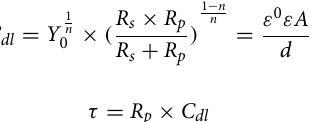
In this equation, R p,0 and R p, i denote the polarization resistance of MS in the inhibitor-free and inhibitor-con- taining solution, respectively. Compared to the blank solution, the sample submerged in the inhibitor-containing solution has a greater R p , as shown in Table 1. It is worth mentioning that as the concentration of the corrosion inhibitor increased, the R p elevated, reaching a maximum of R p = 988.1 Ω cm 2 and η % = 91.3% at 800 ppm after 6 h of immersion. This remarkable improvement is due to corrosion inhibitor adsorption on the MS surface, which establishes a protective layer and blocks the access of the corrosive electrolyte to the metal surface. Nota- bly, the η has dropped slightly after 24 h of immersion, suggesting the extract’s long-term capacity to mitigate corrosion of the MS surface. The Bode diagram can provide more information regarding the corrosion-inhibition activity of FV leaves extract. According to the literature, rising | Z | at the lowest frequency (0.01 Hz) and decreasing the phase angle towards -90° (pure capacitor phase angle) at the highest frequency (10,000 Hz) suggests an increase in corrosion resistance 36 . Table 1 and the Bode graphs show that these two parameters (| Z | 0.01 Hz and phase angle at 10 kHz) for the coupons dipped in the inhibitor-based solution are greater than the blank one, confirming the development of the FV-based protective film on the working electrode’s surface. Further beneficial parameters in corrosion studies are capacitance ( C dl ) and relaxation time ( τ ), which are expressed by Eqs. (2) and (3), respectively 36,42 , and their values are given in Table 1.